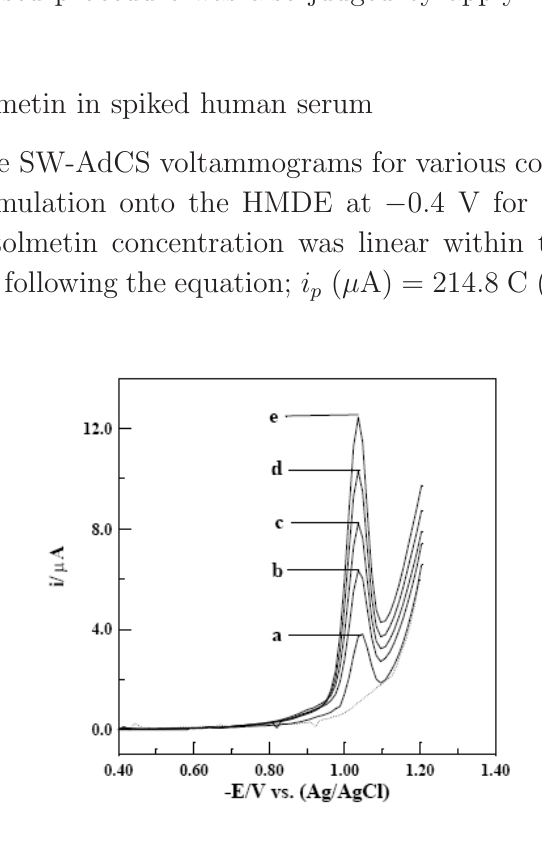
× 10 − 8 , (b) 2 × 10 − 8 , (c)